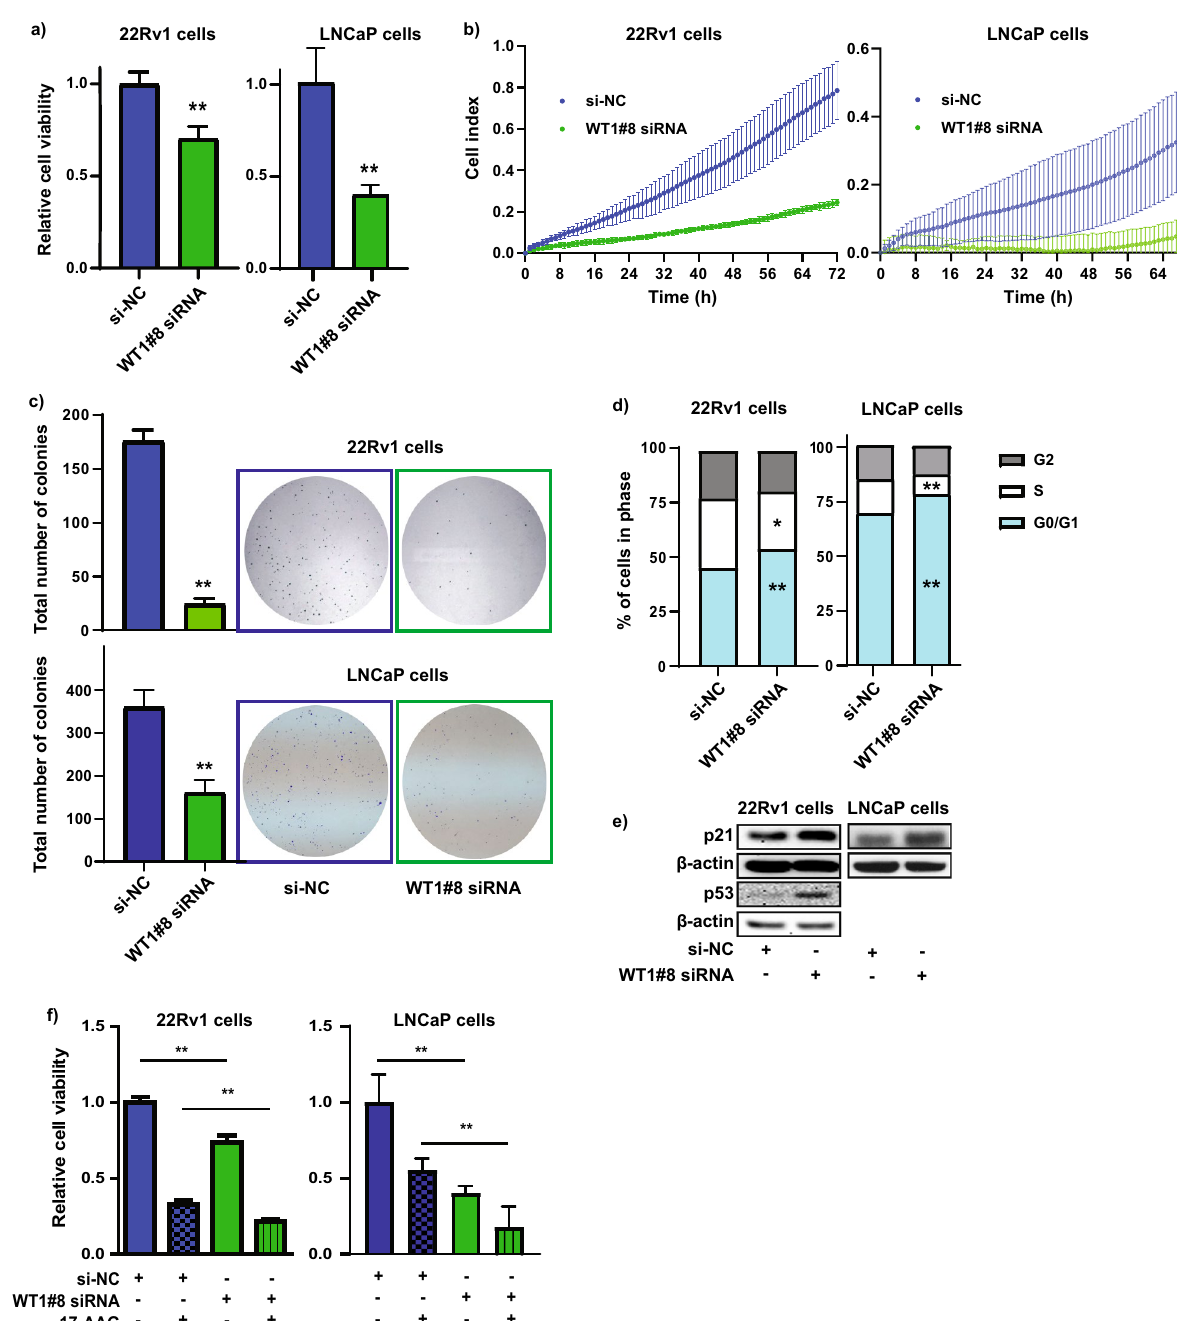
Figure 5. Targeted siRNA-mediated inhibition of WT1 expression reduces PCa cell proliferation and blocks cell cycle progression. ( a ) Relative cell viability of 22Rv and LNCaP PCa cells measured via cell titer assay at 3 d post- transfection with WT1 siRNA or si-NC (20 nM). Validation of WT1 knockdown see Fig. S2B. Error bars = SD; n = 3; ** p < 0.005. ( b ) Proliferation of 22Rv1 and LNCaP PCa cells (cell index) measured using the xCELLigence system post WT1 siRNA or si-NC transfection (20 nM). Validation of WT1 knockdown see Fig. S2C. Error bars = SD; n = 3. ( c ) Colony formation assay of 22Rv1 and LNCaP PCa cells 14–21 days post WT1 siRNA or si-NC (20 nM) transfection. Validation of WT1 knockdown see Fig. S2C. Error bars = SD; n = 3; ** p < 0.005. ( d ) Flow cytometry cell cycle analysis of 22Rv1 and LNCaP PCa cells transfected with WT1 siRNA or si-NC (20 nM) for 72 h. Validation of WT1 knockdown see Fig. S1D. n = 3; * p < 0.05, ** p < 0.005 relative to si-NC. ( e ) Western blot analysis of p21 (22Rv1 and LNCaP) and p53 (22Rv1) protein expression 72 h post-transfection of PCa cells with 20 nM WT1 siRNA or si-NC. β-actin is the loading control. Validation of WT1 knockdown see Fig. S2E. For full-length, non-cropped blots see Fig. S1B and S1C. n = 3. ( f ) Relative cell viability of 22Rv1 and LNCaP PCa cells measured via cell titer assay at 5 days post-transfection with WT1 siRNA or si-NC (20 nM), and 3 d post-17-AAG treatment (1 µM). Validation of WT1 knockdown see Fig. S2B. Error bars = SD; n = 3; ** p <